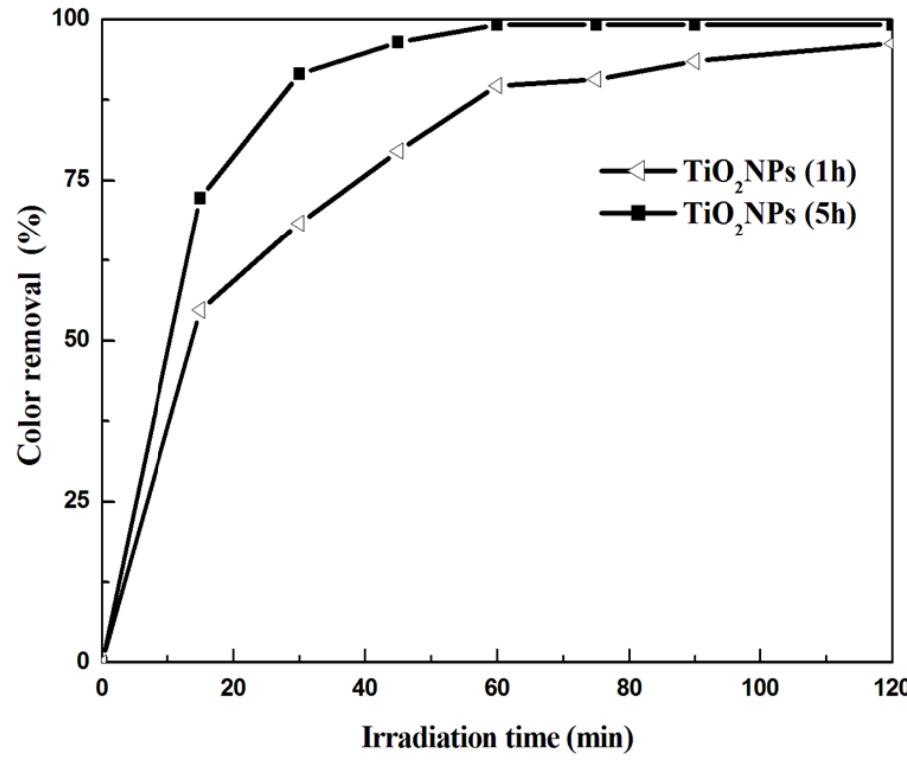
Figure 11. Photocatalytic degradation rates of TiO 2 nanoparticles.